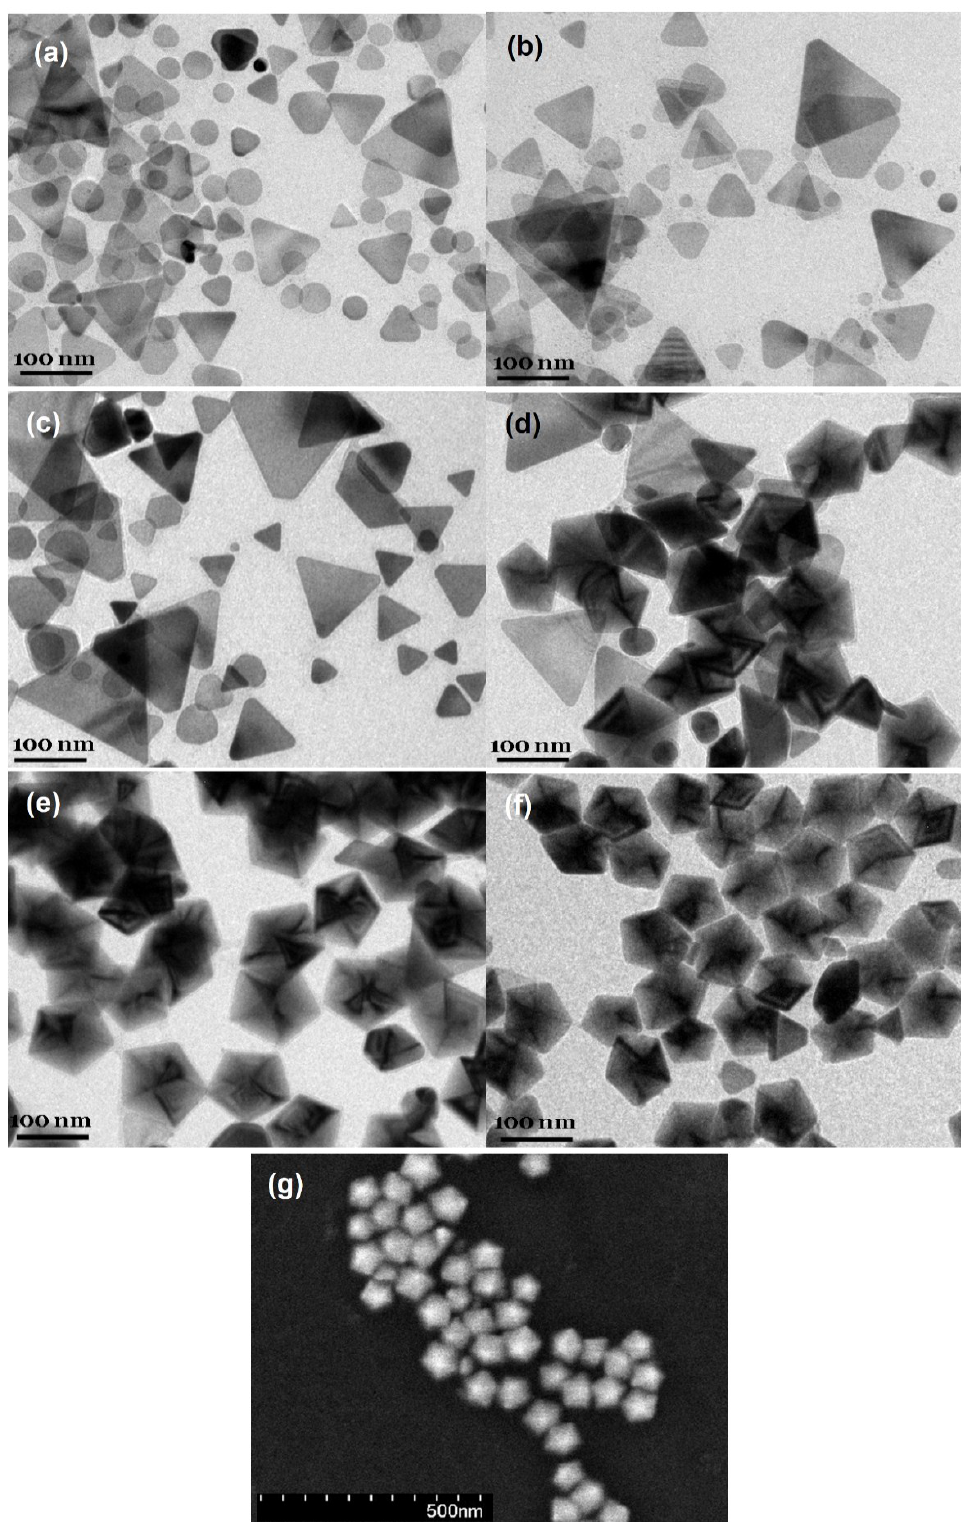
Figure 1. Transmission electron microscopy (TEM) images of the silver nanostructures synthesized at various temperatures: ( a ) 60 °C; ( b ) 40 °C; ( c ) 20 °C; ( d ) 10 °C; ( e ) 5 °C; ( f ) 0 °C and ( g ) the scanning electron microscopy (SEM) images of the silver nanostructures synthesized at 0 °C. The reaction times for 60 °C, 40 °C, 20 °C, 10 °C, 5 °C and 0 °C are 5, 11.5, 25, 45, 72, and 100 h,